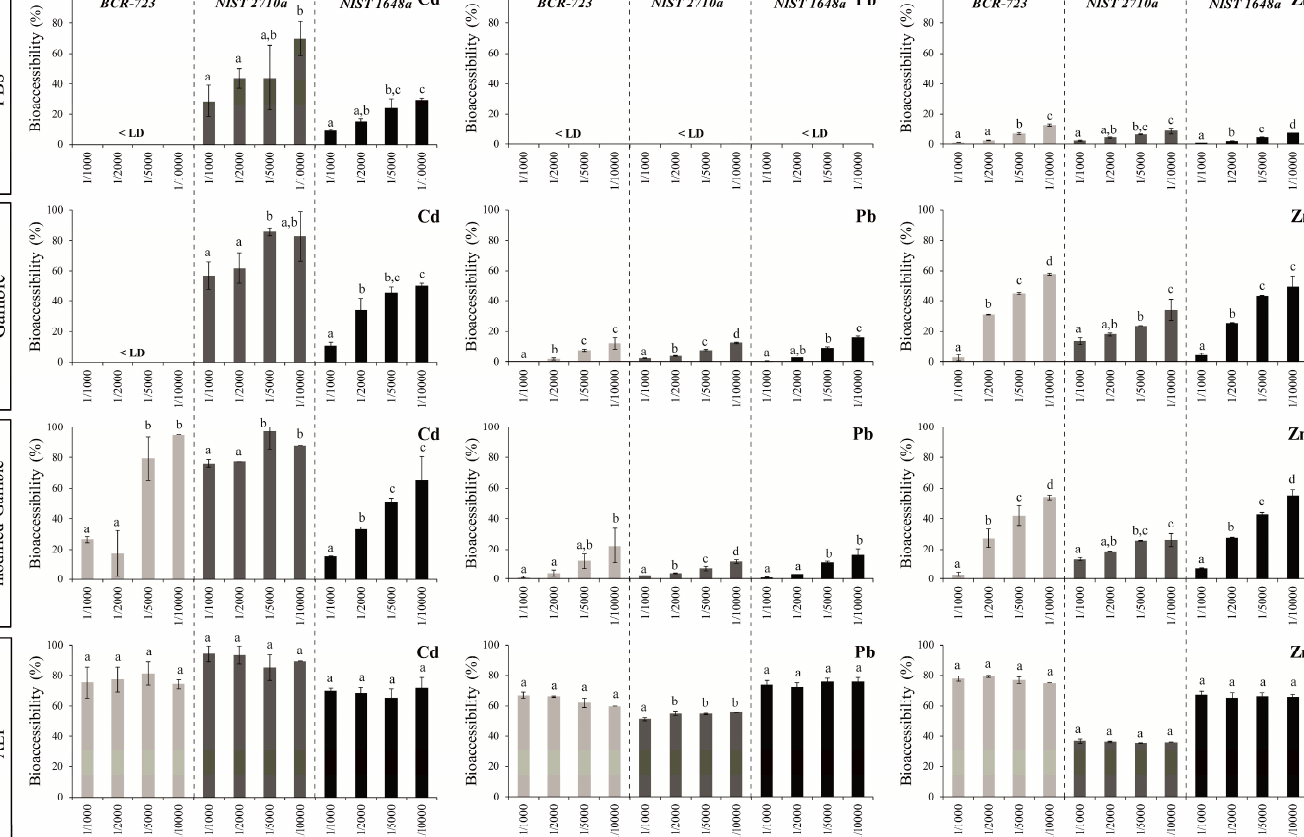
Figure 1. Bioaccessibility values (%; mean and SD; n = 3) of Cd, Pb and Zn in the three reference materials obtained through the four lung fluid extractions according to the four S/L ratios. Lowercase letters (a–d) denote significant differences ( p < 0.05) between the four solid-to-liquid (S/L) ratios for each reference material. LD: limit of detection.